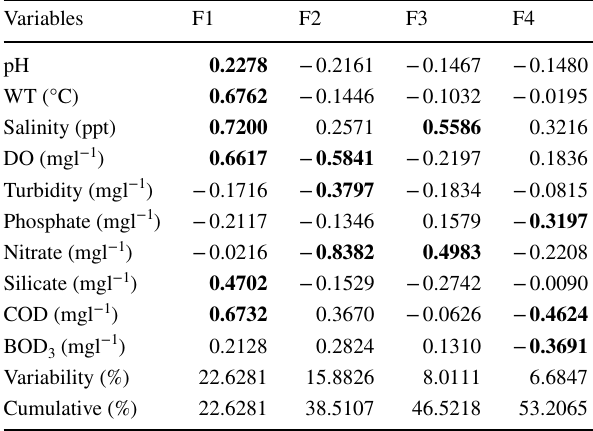
Table 4 Factor analysis of the water quality parameters after varimax rotation